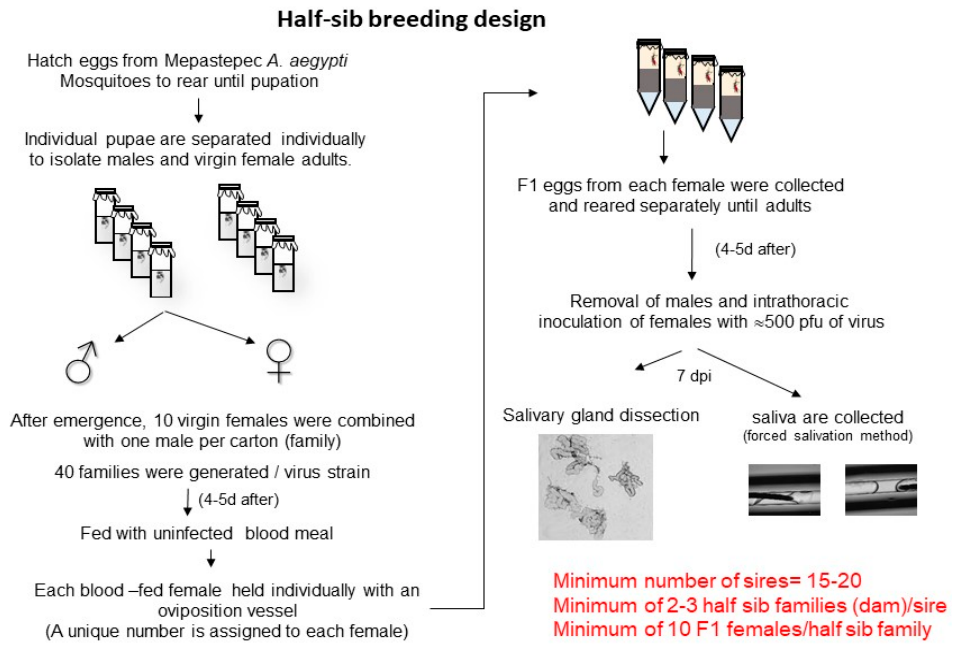
Figure 3. Method for generating nested half-sib design used for calculating estimates of genetic and environmental variances and covariances.